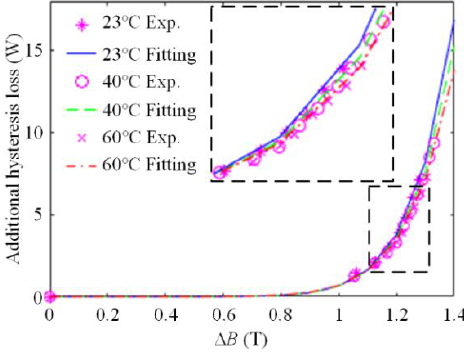
Figure 6. The relation of experiment results and fitting curves.